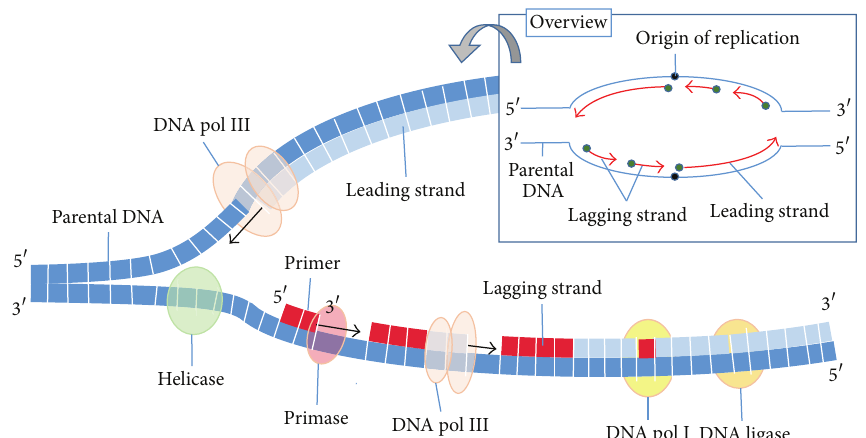
Figure 2: Synthesis process in bacterial DNA replication.